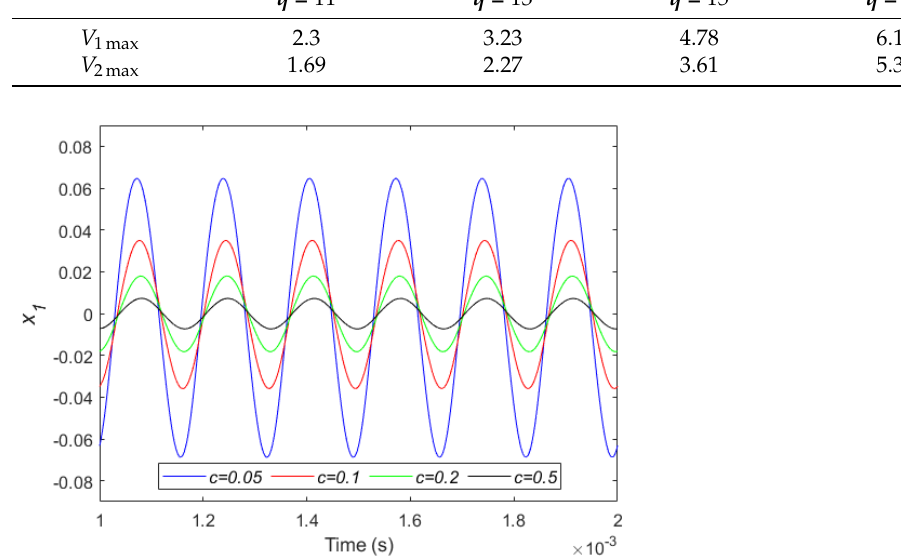
Figure 10. Variation of x 1 versus time for various amounts of c and considering p = 19, q = 17, and 1 β = 50.